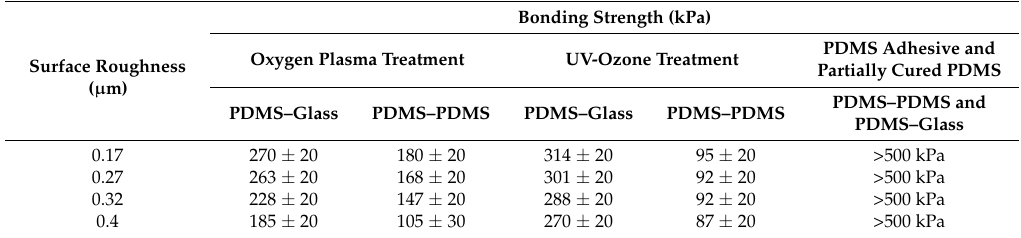
Table 8. Comparison of surface roughness with bonding strength using various bonding